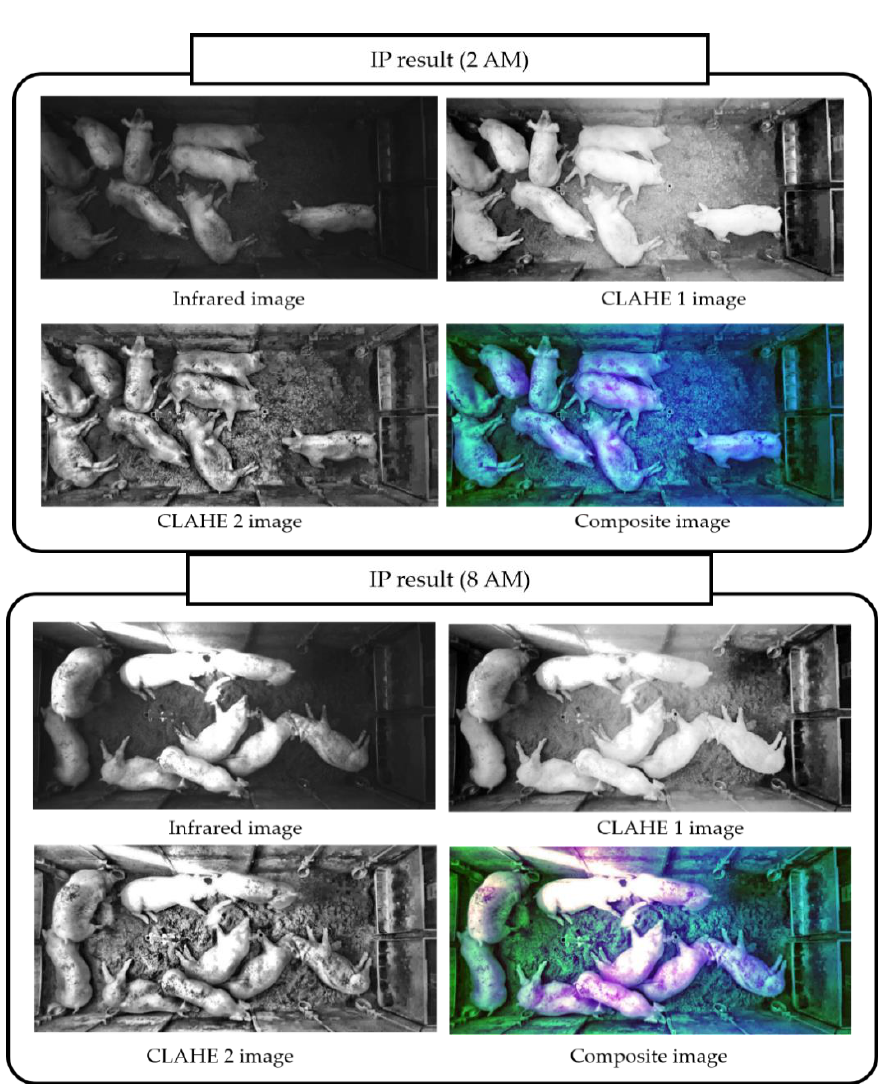
Figure 3. Infrared, CLAHE1, CLAHE2 and composite images at different illumination conditions.